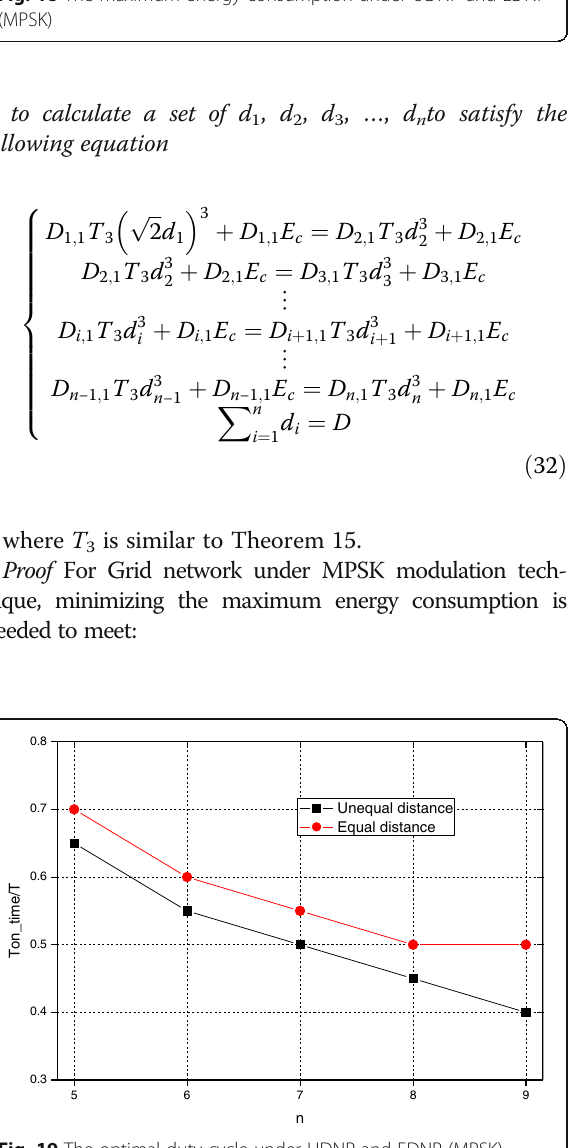
Fig. 19 The optimal duty cycle under UDNP and EDNP (MPSK)